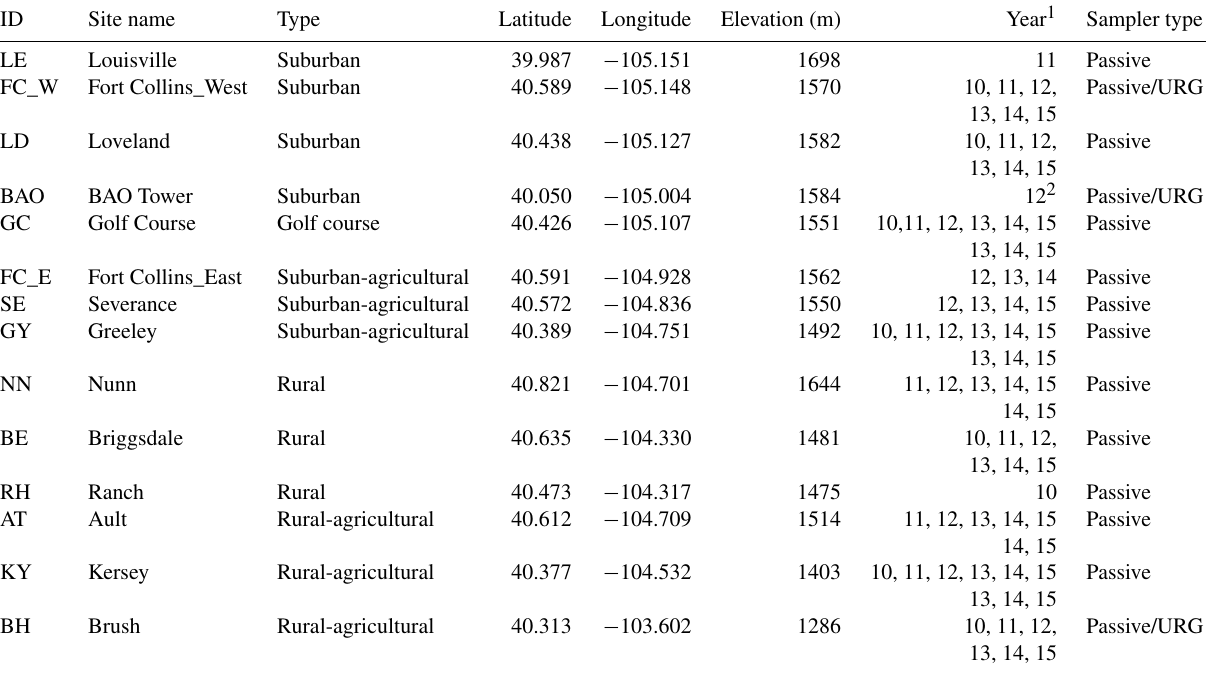
Table 1. Summary of sampling site locations and